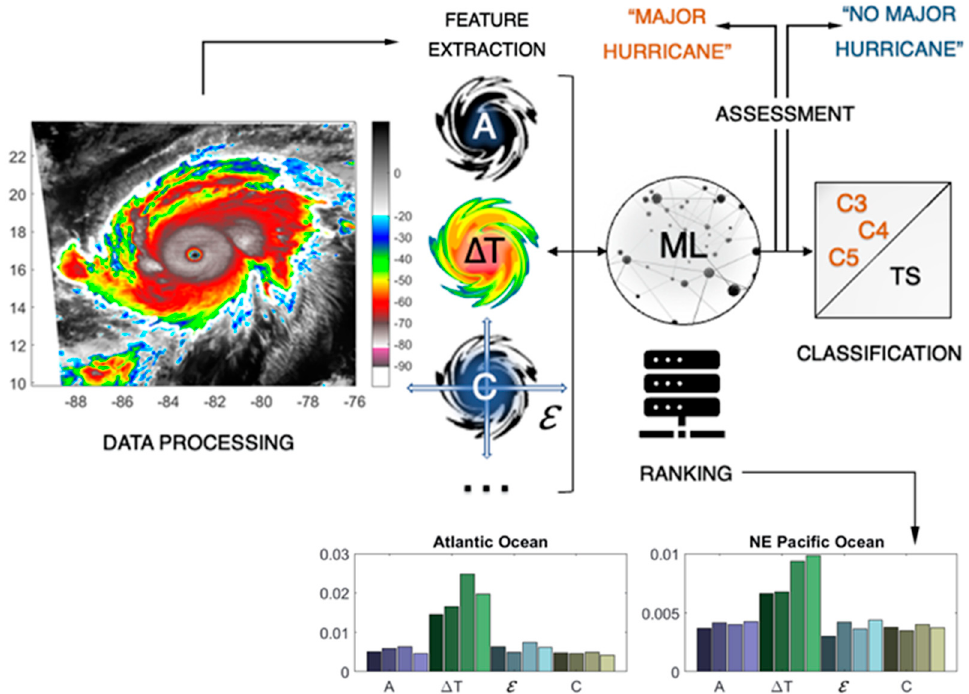
Figure 2. Exemplification of our hybrid ML approach. After all the GOES images are converted to BT, some hurricane-related parameters are extracted using a k-means clustering method. Then, the most important parameters, according to our RF classifier, are used to predict the intensification of a TS to MH status. Among all considered parameters, the most relevant ones are the following: the area, or A, estimated from the shape (displayed as white contour line); the temperature difference between the inner core and outer part of the storm cloud, or ∆ T; and the morphology (circularity, or C; eccentricity, or 𝜺 ). This ML framework sets the basis for the classification-oriented categorization of hurricanes based on key criteria (related to the anatomical and temperature features of a TC, in this study). The ability of ML in dealing with different types of ever-shifting TC features and with missing knowledge is highly important under the impact of climate change. The image (on the left side) corresponds to Hurricane Mitch (26 October 1998, at 14:45 UTC) in the Atlantic. The variable-importance plots (on the bottom) are for several lead-times (in colors) before the TCs reach their maximum intensity in the Atlantic and NE Pacific oceans. C3, C4, C5 stand for category 3, 4, 5 hurricanes, respectively, and make up the MH class.